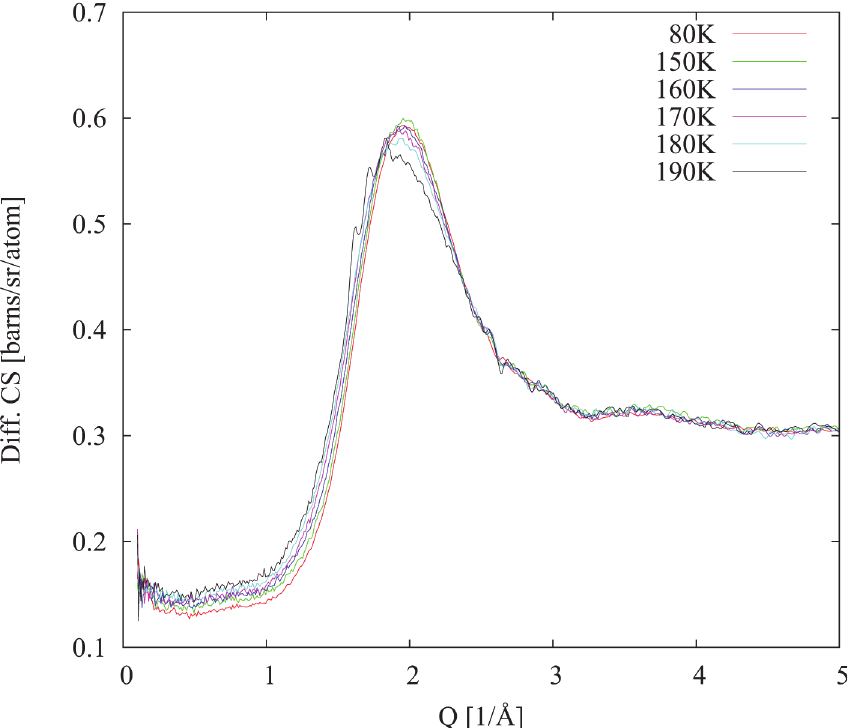
Fig 3. Differential cross sections for fully deuteriated sample. Second heating after initial quench cooling. The small peaks seen in the 190K data indicate some ice crystallisation in this sample (for more details see